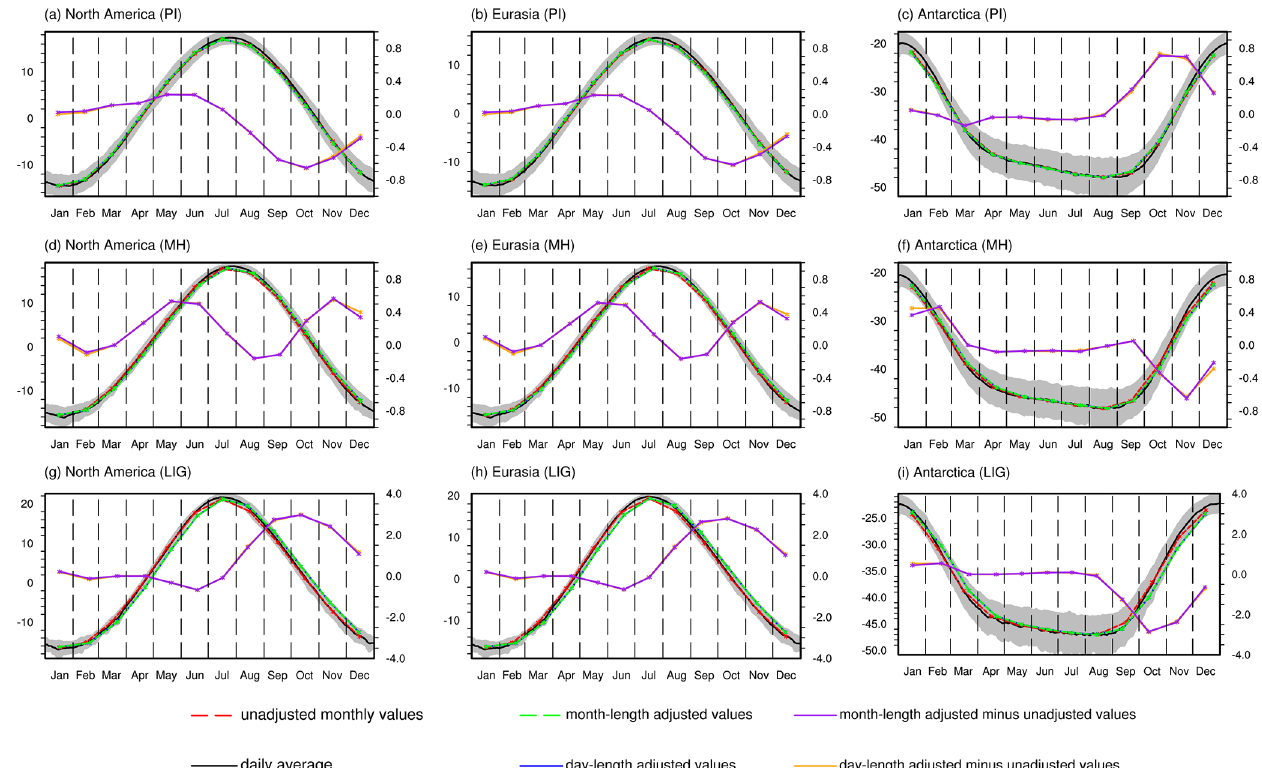
Figure 10. Ensemble seasonal cycle of regional mean surface air temperature in daily average (black solid lines), classical monthly means (red dashed lines), day-length adjusted means (blue dashed lines), and month-length adjusted means (green dashed lines) for (a–c) PI, (d– f) MH, and (g–i) LIG (axis to the left). Grey area represents one standard deviation from the multi-model ensemble daily mean values. Purple (orange) solid line represents the month-length (day-length) adjusted minus unadjusted values, axis to the right. The values are calculated by averaging the surface air temperatures over (a, d, g) North America, (b, e, h) Eurasia, and (c, f, i) Antarctica. Units: ◦